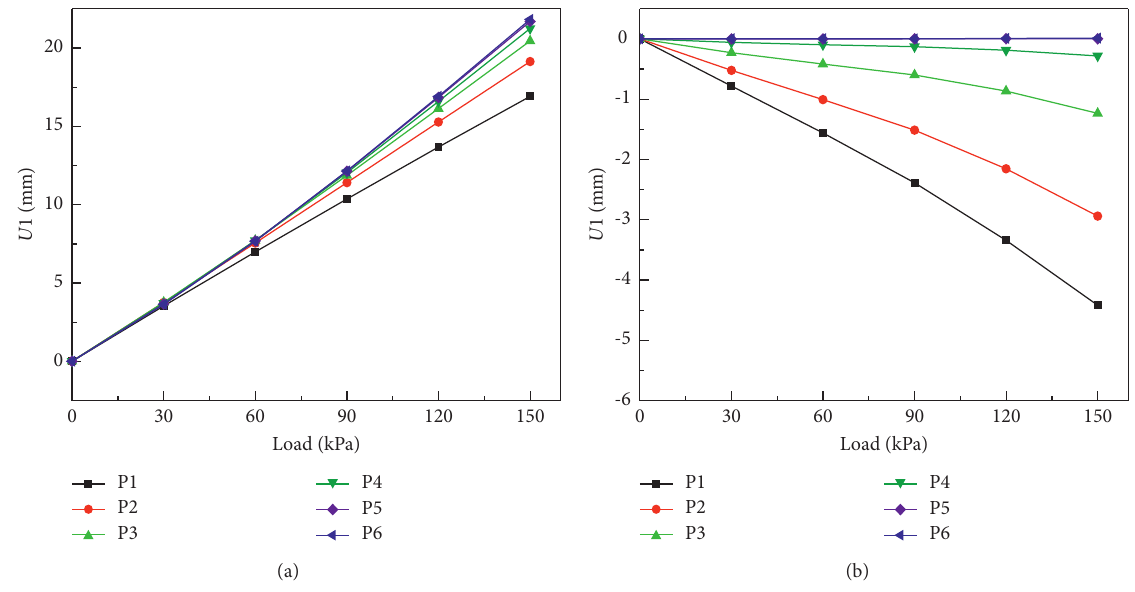
Figure 11: Displacement at the pile top (3-16): (a) U1; (b) U2.